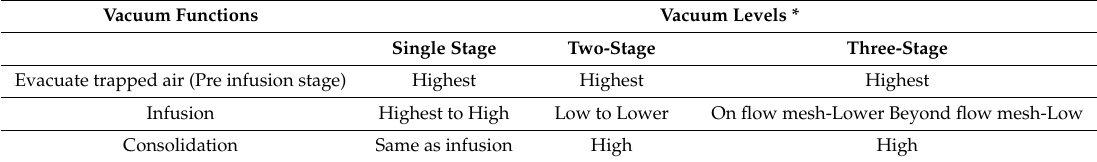
Table 5. Vacuum levels used in single and multi-stage phases of infusion process.